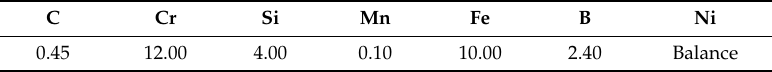
Table 1. Chemical compositions of Ni45 nickel-based alloy powder (wt.%).